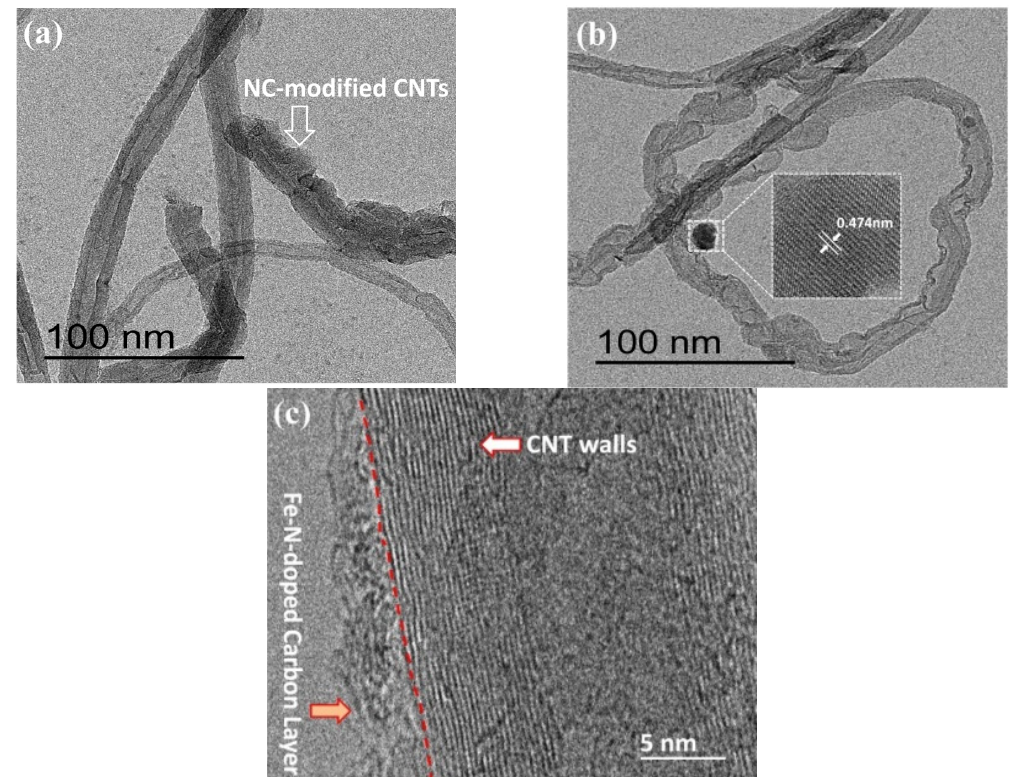
Figure 2. HR-TEM images of N-C@CNT ( a ) and N-C@CNT-Fe ( b , c ).